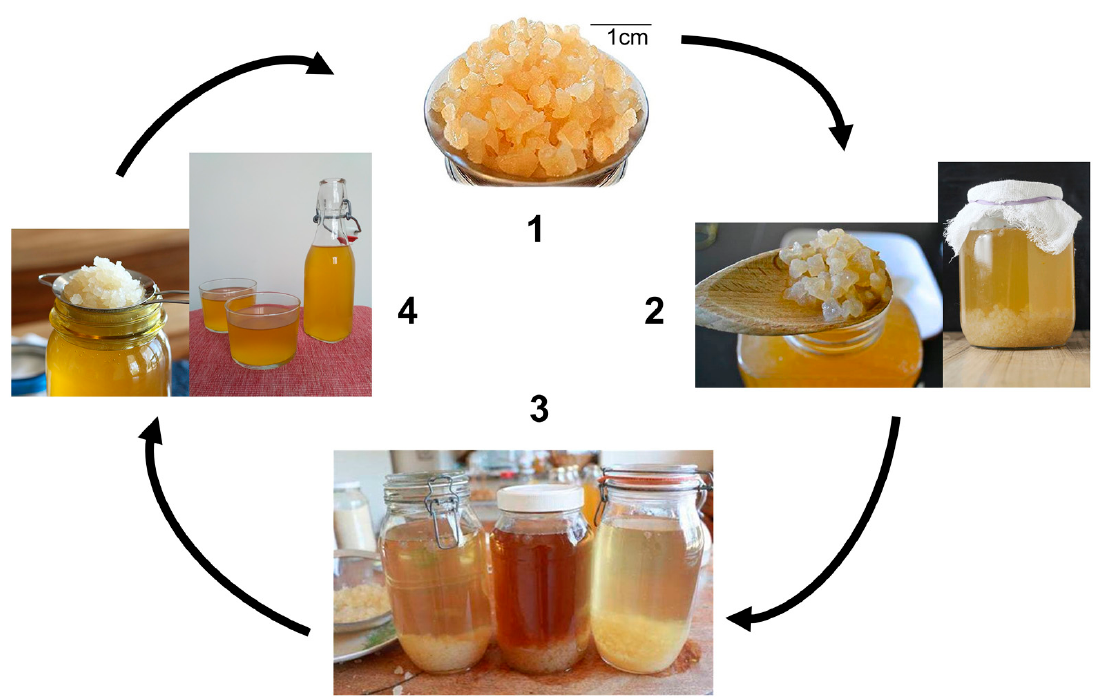
Figure 1. Water kefir beverage production. Water kefir grains (1), kefir grains in fermentation process (2), fermented kefir beverage (3), recovered kefir grains (4). Original and unpublished figure (authors’ archive).